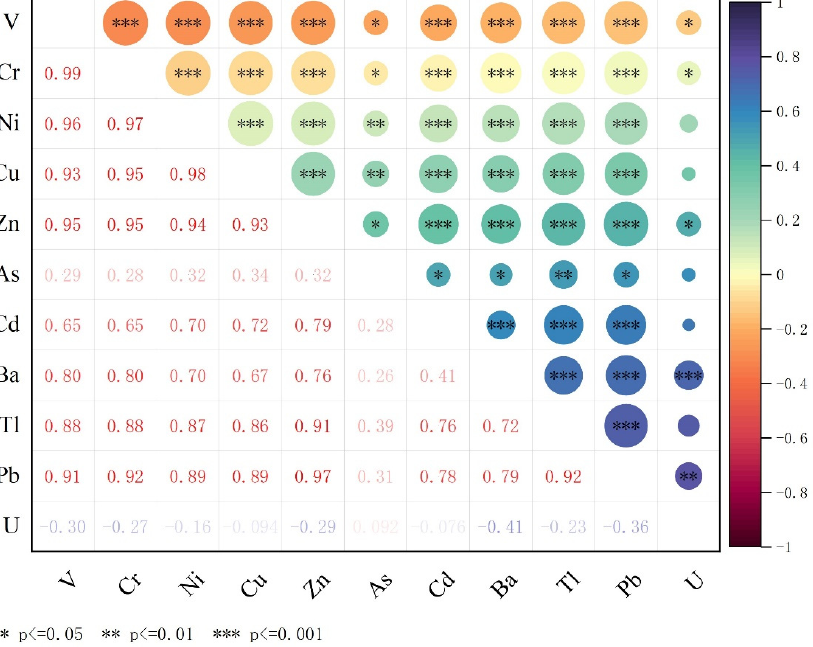
Figure 3. Correlation coefficient matrix between trace elements co-occurrence for sediment in lakes in the Qaidam Basin ( * Represents p -value ≤ 0.05; ** Represents p -value ≤ 0.01; *** Represents p -value ≤ 0.001 ).